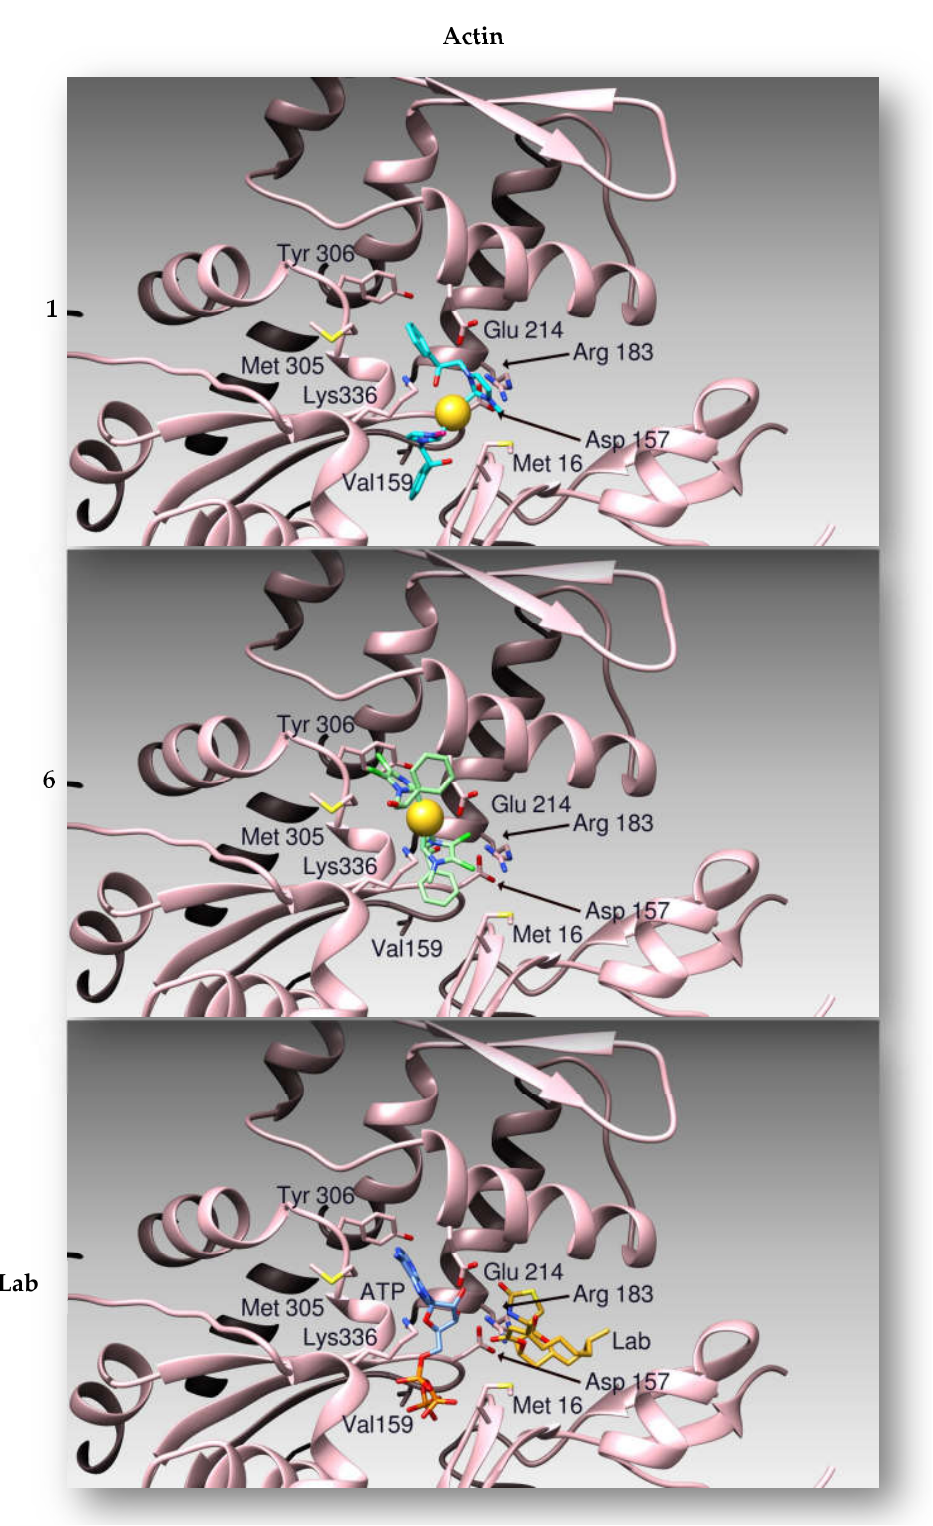
Figure 8. Ribbon representation of the binding modes of compounds 1 , 6 and Latrunculin B (Lab) to Actin. The proteins are drawn as pink ribbons. Compound 1 is drawn as light blue sticks, while compound 6 as green sticks. The binding pose of Latrunculin B (Lab), as determined by X-ray crystallography, is reported as gold sticks.